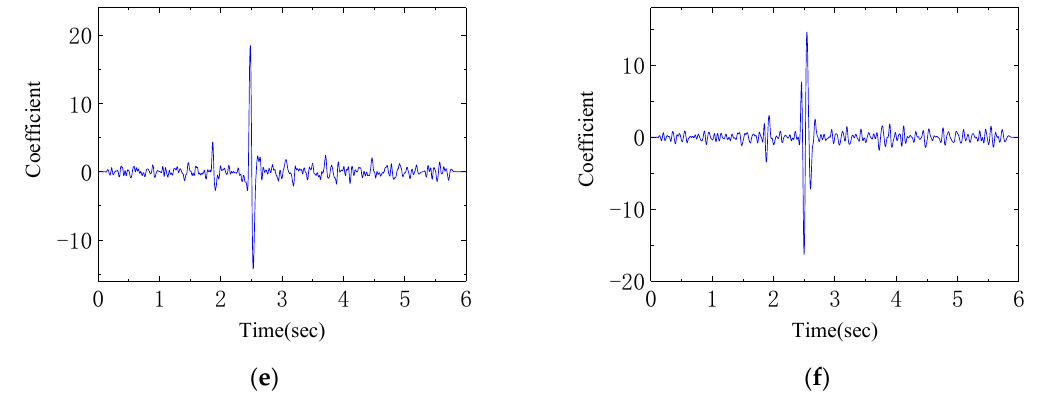
Figure 11. Wavelet coefficients for different mother wavelets and scales: ( a ) db2 , scale = 8 (optimal); ( b ) db2 , scale = 4 (less than optimal); ( c ) db2 , scale = 16 (greater than optimal); ( d ) db1 , scale = 7 (optimal); ( e ) db3 , scale = 9 (optimal); ( f ) db6 , scale = 10 (optimal).